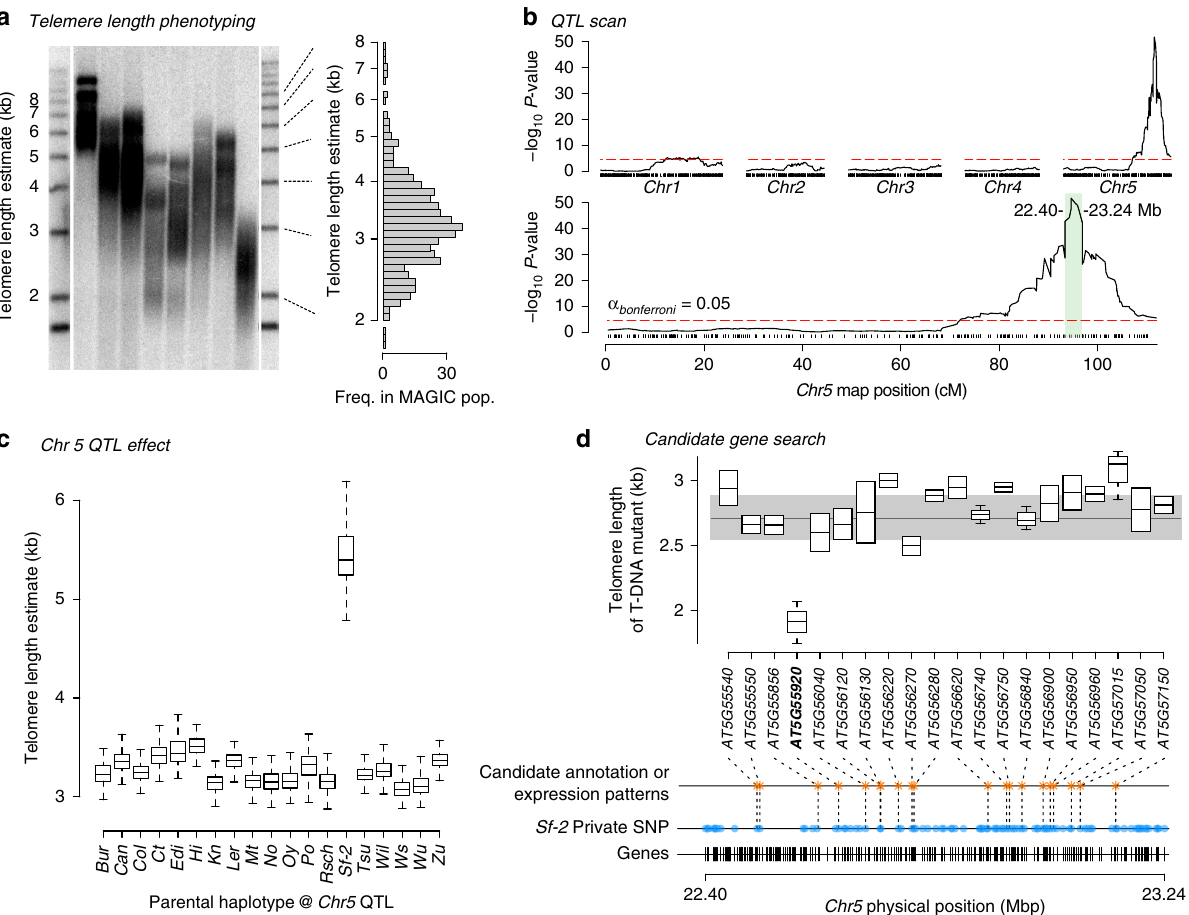
Fig. 2 Genetic mapping of telomere length variation in Arabidopsis. a Representative TRF gel of telomere length variation in A. thaliana MAGIC lines. Each lane corresponds to genomic DNA from a randomly selected MAGIC line. Overall pattern of mean telomere length distribution (in kb) in the MAGIC lines is shown on the right. b QTL scan of mean telomere length in the MAGIC population. The majority of natural genetic variation in telomere length of Arabidopsis MAGIC lines is explained by a large effect QTL on chromosome 5 (upper panel). The horizontal lines indicate the genome-wide Bonferroni- corrected threshold for QTL signi fi cance (alpha = 0.05). The major effect QTL is localized to ~848 kb on the right arm of chromosome 5 (lower panel). c Estimates of contribution of 19 parental haplotypes at the major effect chromosome 5 QTL to telomere length (in kb) in Arabidopsis thaliana MAGIC lines. Plants that inherited the rare Sf-2 allele show a 88.1% increase in telomere length. Error bars represent standard errors for each haplotype. d The high con fi dence ~848 kb QTL interval on chromosome 5 contains 247 genes (black bars, bottom), of which 110 genes harbor one or more Sf-2 speci fi c polymorphisms (blue dots). Of these, 20 genes were selected for transgenic analysis (orange asterisks) due to the presence of private Sf-2 alleles, statistical differences in expression between Sf-2 and other parental accessions or due to interesting annotation. Knockouts of 19 of these genes harbor telomeres in the normal range for the wild type Col-0 accession (gray shaded area). Transgenic T-DNA knockouts of At5g55920 gene (in bold) showed the strongest effect on telomere length, indicating that variation at this locus may be responsible for the observed